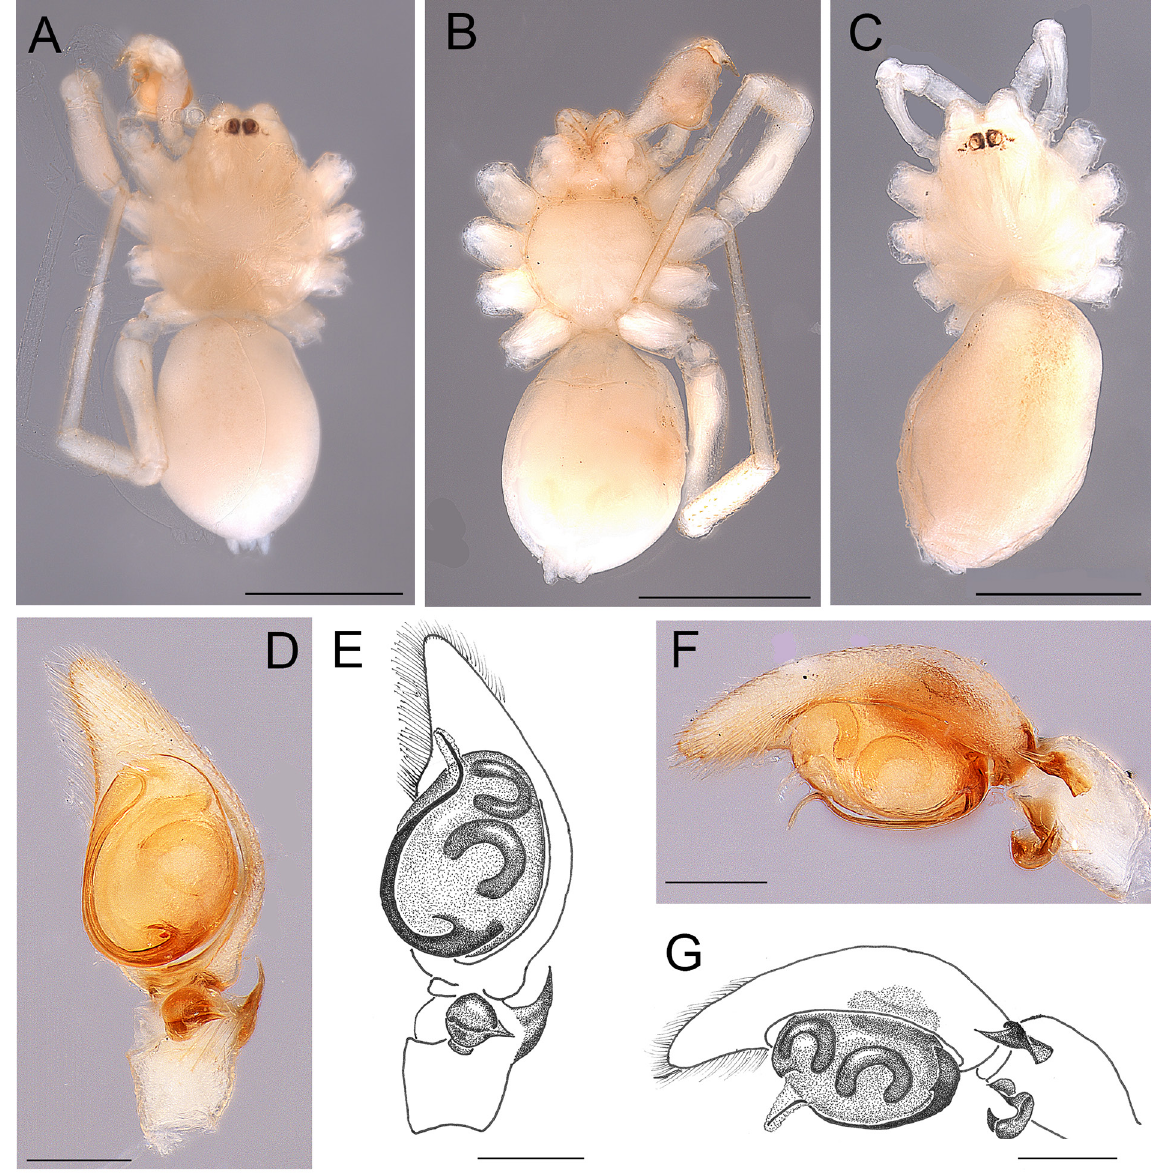
Fig. 6. Andromma albinovani sp. nov. A–B, D–G . ♂, holotype (BE_RMCA_ARA.Ara 177497). C . ♀, paratype (BE_RMCA_ARA.Ara 177497). A, C . Habitus, dorsal view. B . Same, ventral view. D–E . ♂, left palp, ventral view. F–G . Same, retrolateral view. Scale bars: A–C = 1 mm; D–G = 0.2